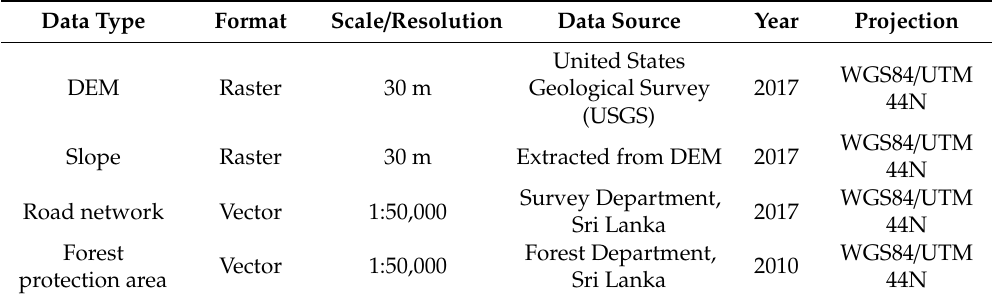
Table 1. Descriptions of the spatial data used in the